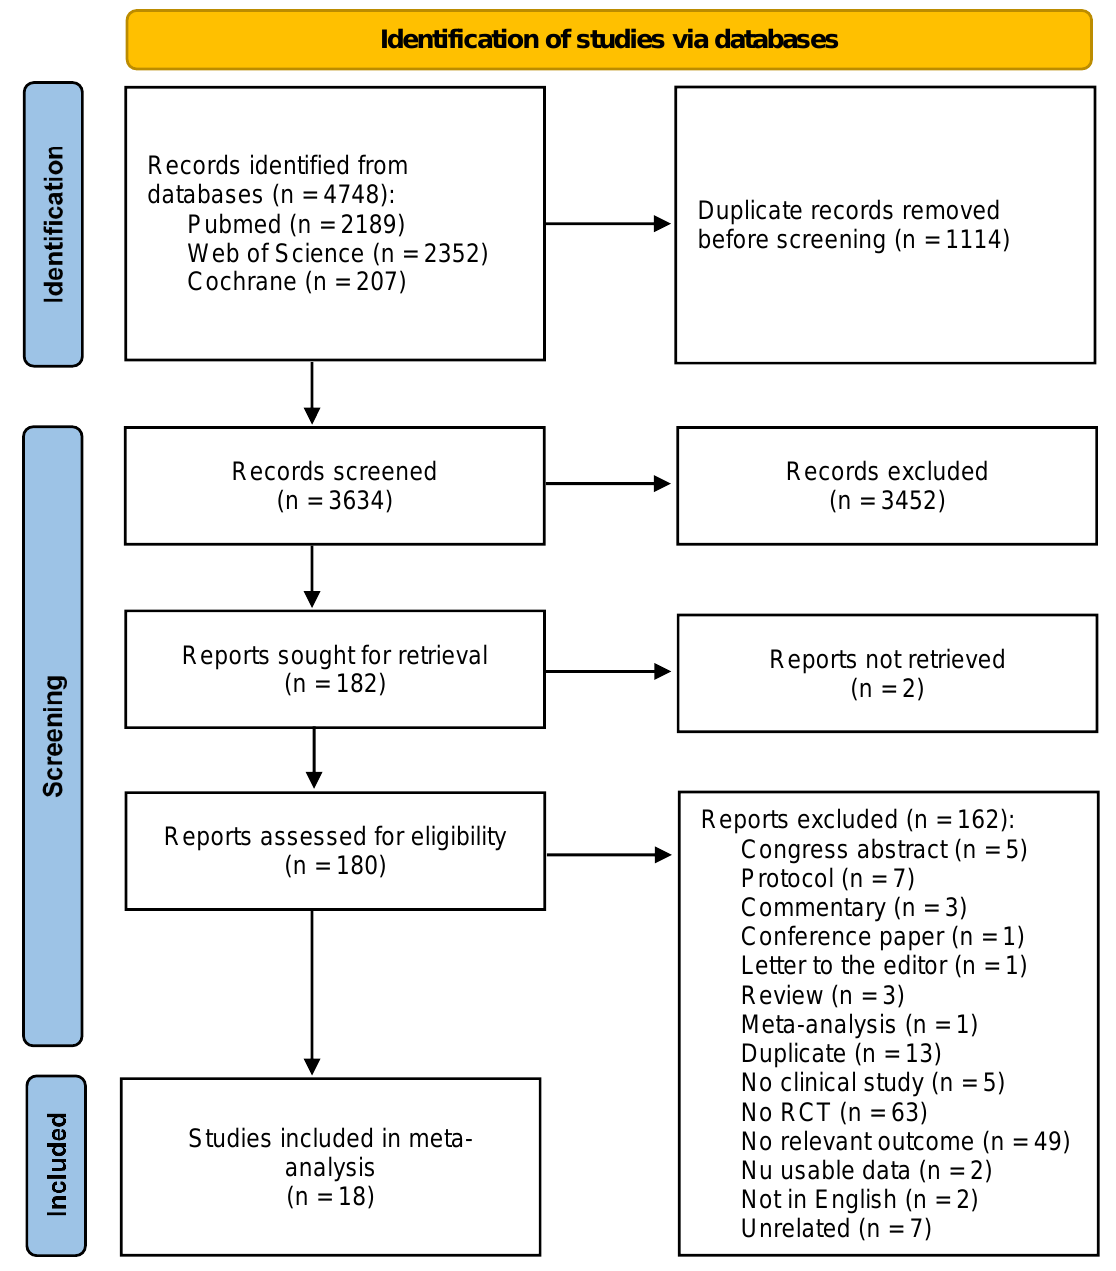
Figure 2. Study selection flow chart.